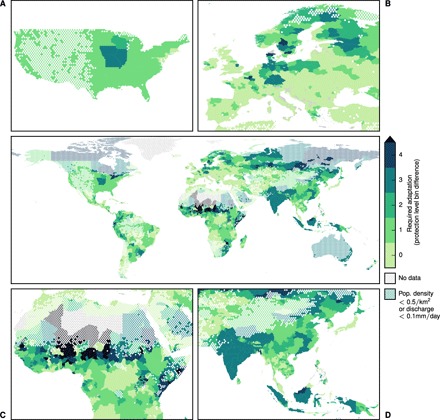
Increase in the regional flood protection level required to preserve the current high-end flood risk for the period 2035 to 2044 (realization ensemble median).Additional protection is given in levels, starting with 0 for regions without adaptation need. Level boundaries are 0, 1, 2, 4, 8, 16, 32, 64, 128, 256, 512, and 1000 years return period. Numbers shown are absolute difference in level numbers to current protection per subnational region in the FLOPROS database (6). Subfigures show regional foci on the (A) United States, (B) Europe, (C) Africa, and (D) Southeast and East Asia.